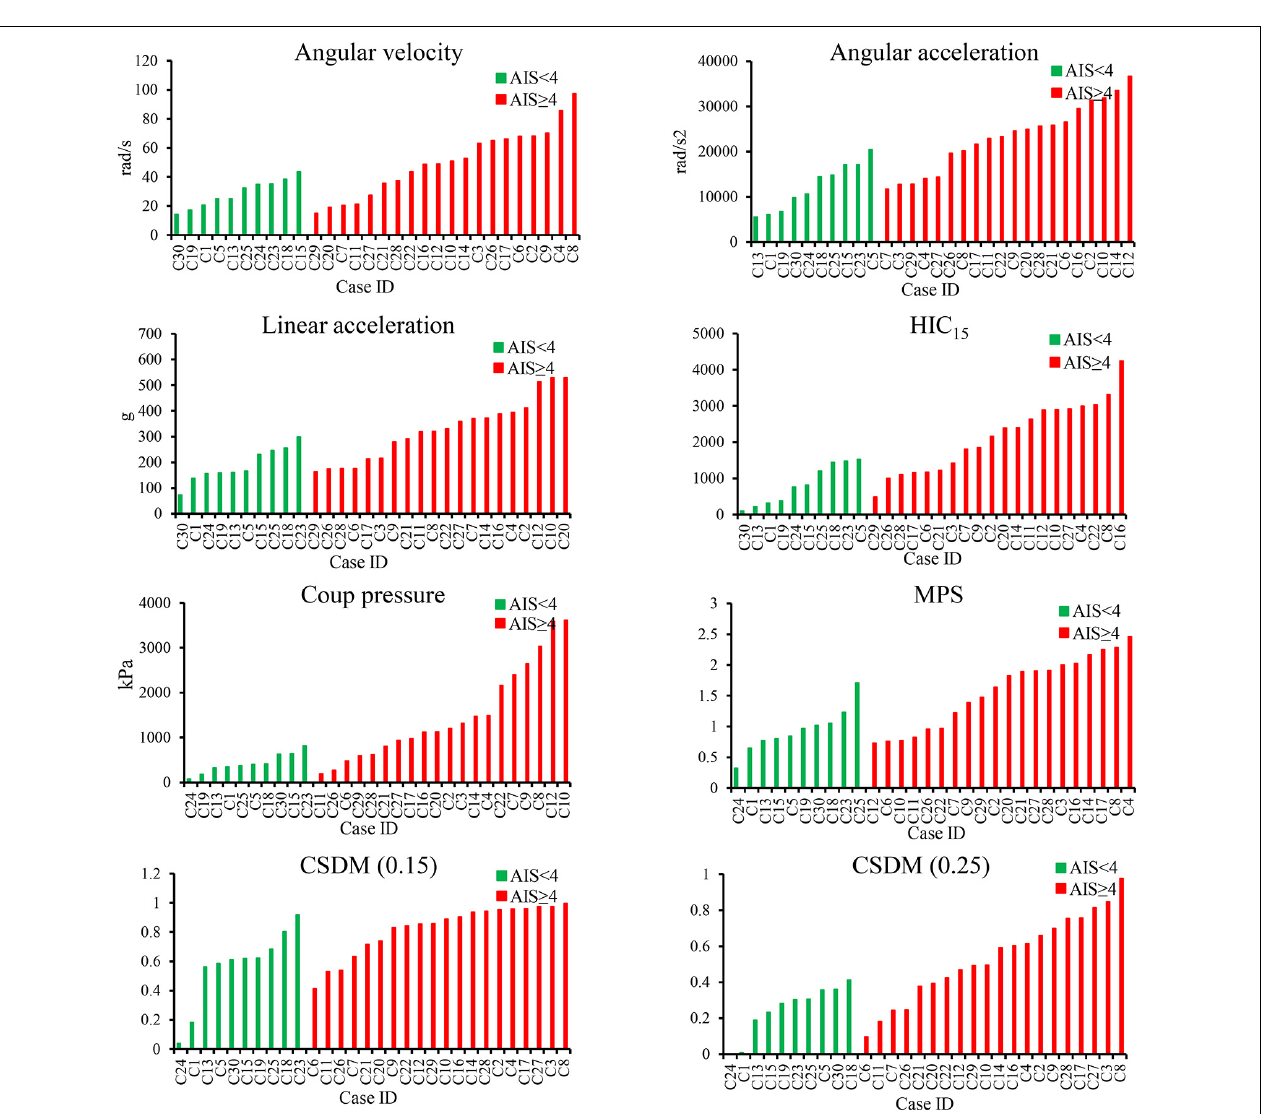
FIGURE 3 | Simulated results of all head injury